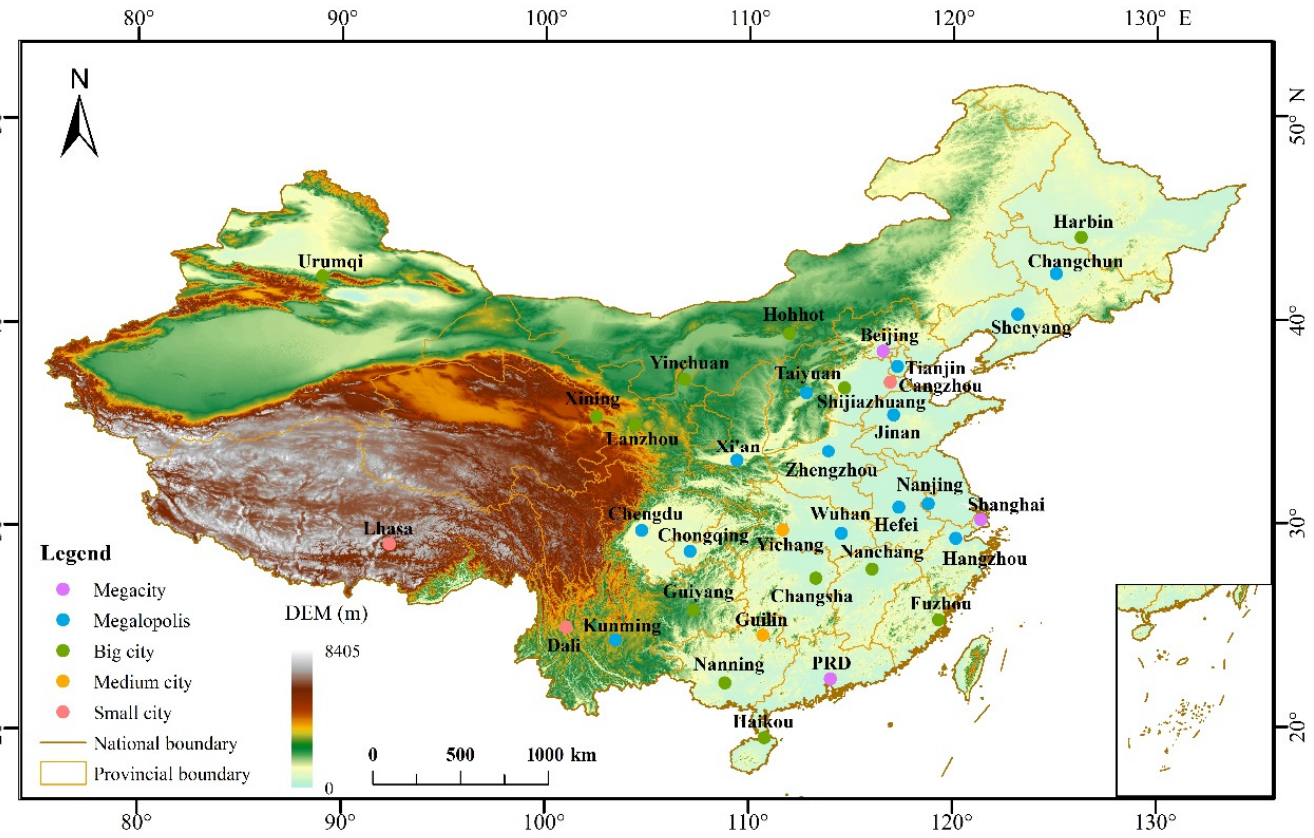
Figure 1. The geographical distribution of 35 cities in China. Table 1. The classifications of 35 cities in China .